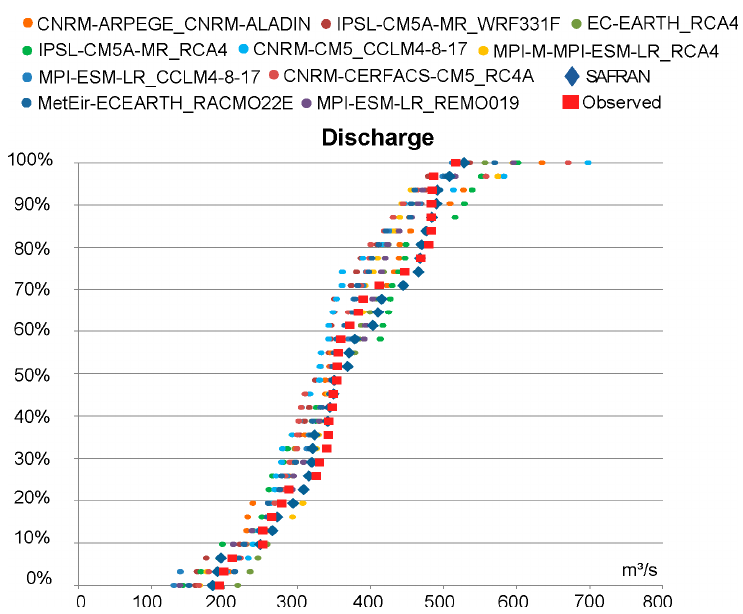
Figure 4. Comparison of discharge simulated from each dataset: climatic ensembles (historical period) and the SAFRAN dataset. (Names as